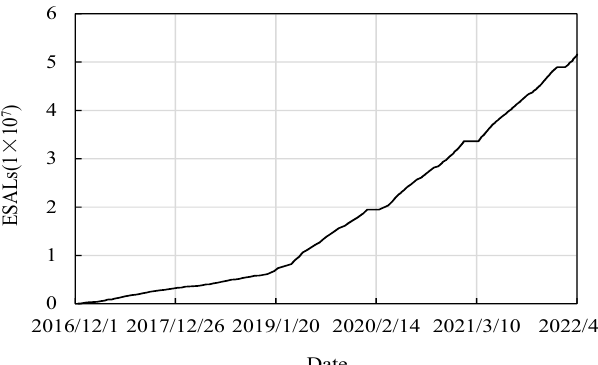
Figure 5. Curves of the cumulative number of equivalent single-axle loads.